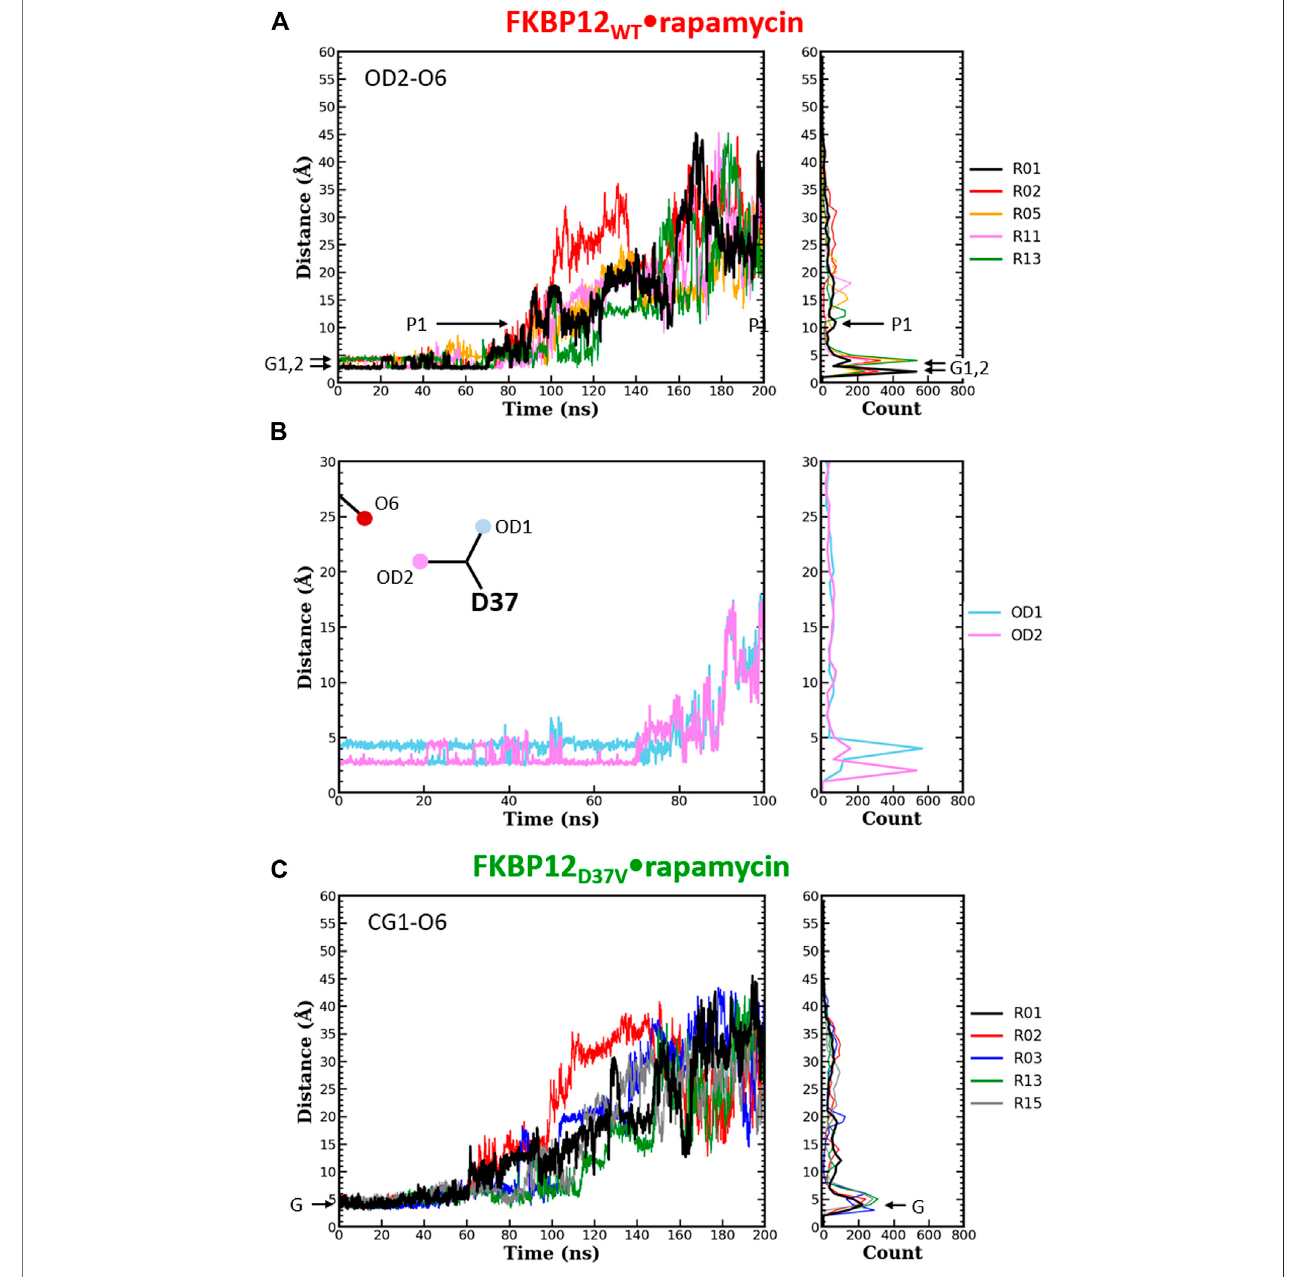
FIGURE4| Comparison ofthe separation distance patternsobtained during thedissociationofrapamycinfrom thewild-type FKBP12 and from theD37V mutant. Pulling on the molecular partners CoG starts at 10 ns. (A) Evolution of the distance between the O6 hydroxyl oxygen of rapamycin and the OD2 carboxylate oxygen of (cid:129) residueD37intheFKBP12 WT rapamycincomplex.Forthesakeofclarity,thedataareonlyprovidedfortheR01lower-boundPMFpro fi leandforfourotherones.TheGi andPimarkersindicate,forthetime-traceandthehistogramassociatedwiththelower-boundpro fi le,thegroundlevelsandthedifferentplateaus,respectively.The data for all 15 CPUS simulations are displayed in Supplementary Figures S10A . (B) Enlargement on the fi rst tens of ns of the time-trace associated with the lower- bound PMF pro fi le. The distance to the second carboxylate oxygen of residue D37 (OD1) has been added to evidence the H-bond switching between the two acceptor atoms. SupplementaryFiguresS10A providessimilardataforthewholesetofsimulations. (C) EvolutionofthedistancebetweentheO6hydroxyloxygenofrapamycin (cid:129) and one of the CG1 methyl carbon of residue V37 in the FKBP12 D37V rapamycin complex. Once more data are only provided for the R01 lower-bound PMF pro fi le and for four other ones, see Supplementary Figures S10B for an exhaustive presentation of the